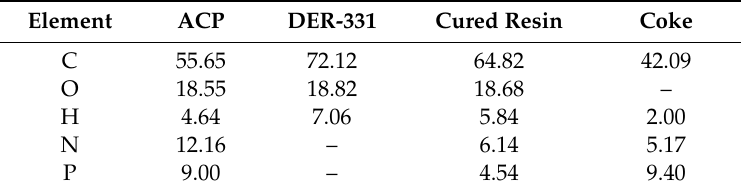
Figure 8. 3D FTIR spectra of the pyrolysis gas products of ACP cured composition from TGA ( a ) and FTIR spectra of pyrolysis gas products at different temperatures ( b ). Table 1. The elemental content of the substances (wt. %).